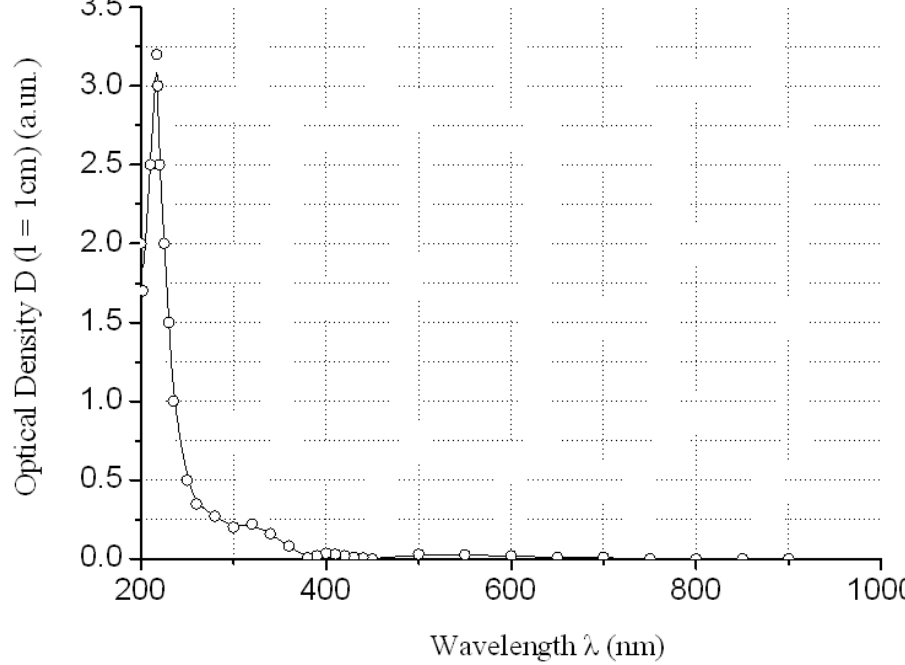
Figure 5. Electronic spectrum of water solution of TbCl 3 at concentration C TbCl3 ≈ 21.3 g/dm 3 relatively distilled H 2 O.